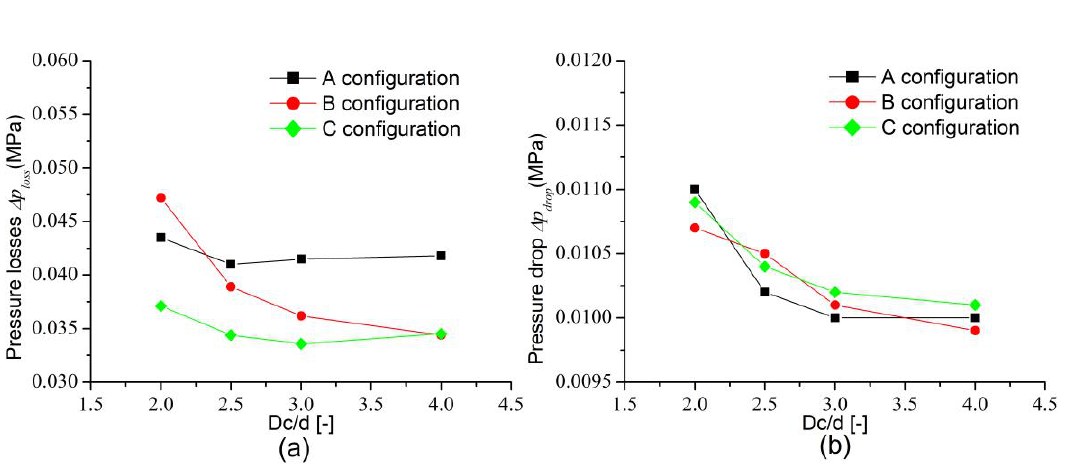
Figure 7. Influence of clustered pipe diameter on: ( a ) pressure loss; ( b ) pressure drop.